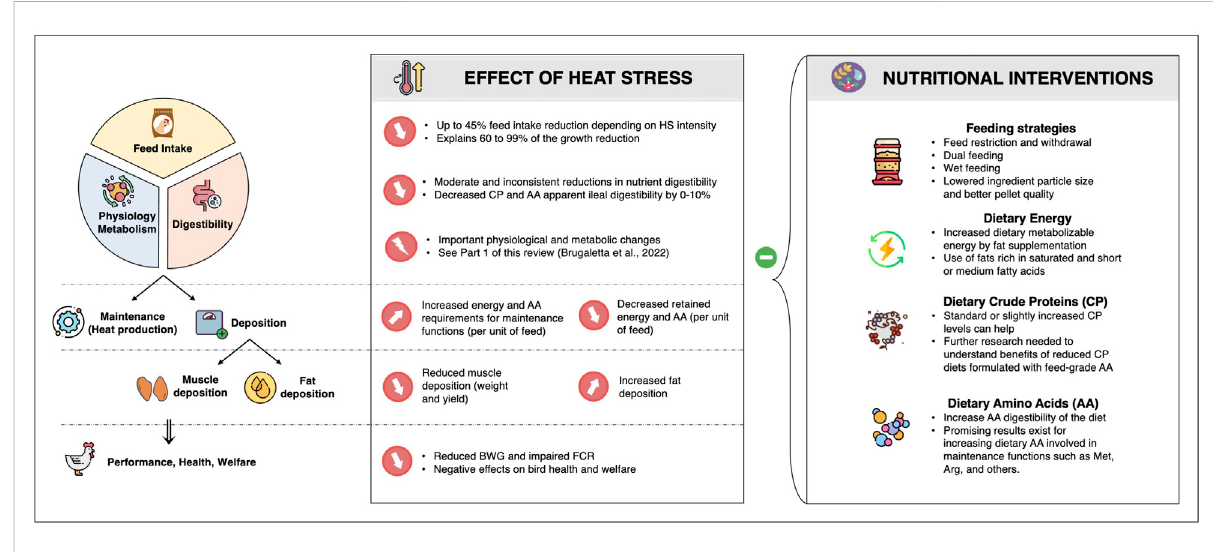
FIGURE 3 Conclusive scheme of the bene fi cial nutritional interventions on broilers exposed to heat stress